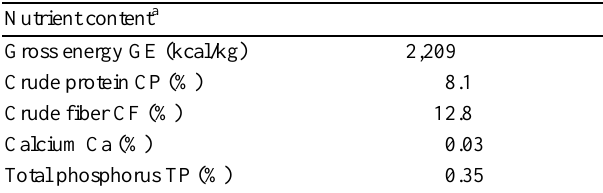
Table 2. Nutrient content of paddy rice Nutrient content